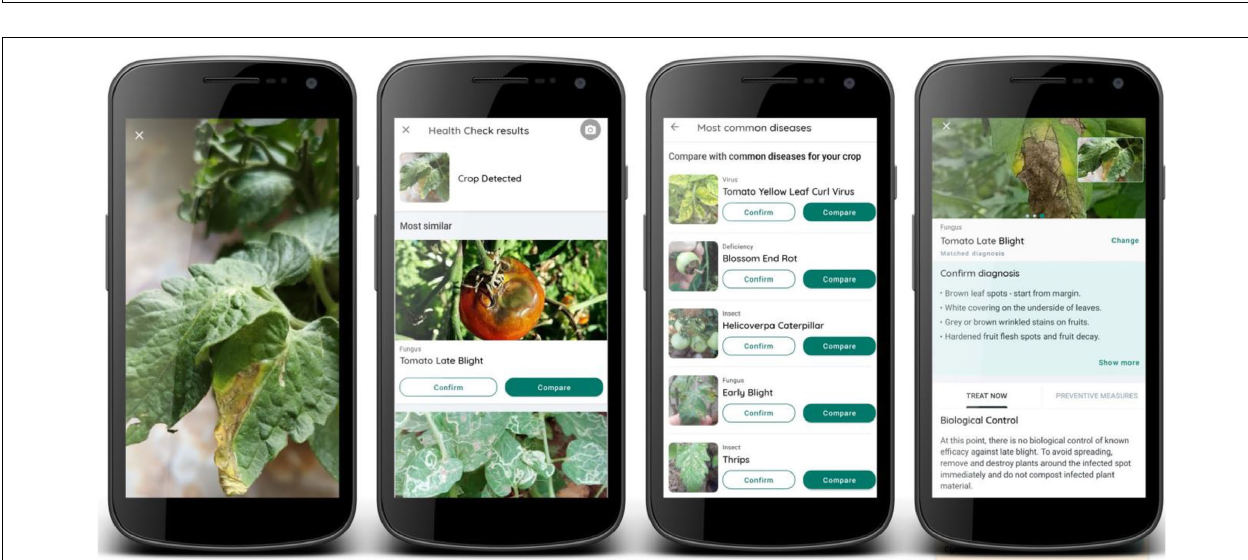
FIGURE 2 | Function flow of the smartphone application Plantix: (1) The user takes a picture of the diseased plant organ. (2) ConvNets classify the image. (3) The user confirms or rejects the diagnosis. (4) The app displays additional information on symptoms, preventive measures and P&A control mechanisms.